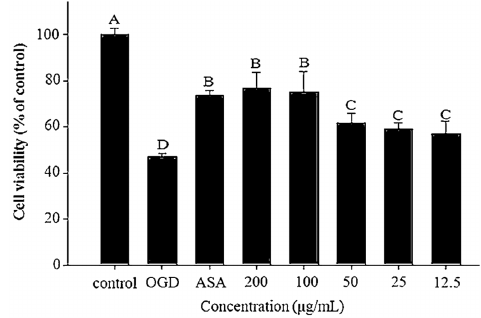
Figure 2. Effect of the ethanol extract of TWK10-fermented soymilk on cell viability of oxygen-glucose deprivation (OGD) model in PC ‐ 12 cells; ata are presented as means ± SD ( n = 3); Bar values bearing different letters were significantly different in accordance by Duncan’s multiple range test ( p < 0.05); ASA: ascorbic acid (100 μ g/mL).